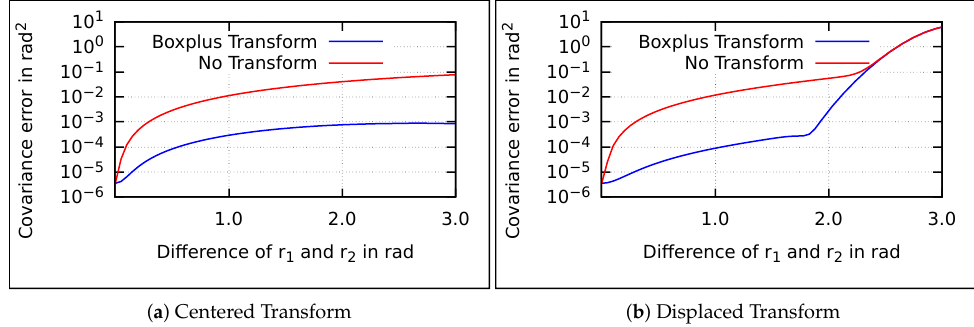
Figure 5. The covariance error (Schur norm) in logarithmic scale of the (cid:1) -transform and no transform compared to numerical optimal transformation over the angular differences of r 1 and r 2 .